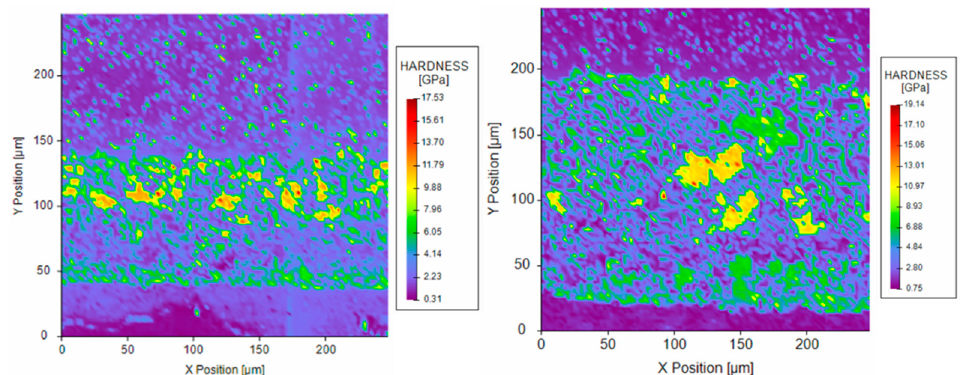
modulus of elasticity contour plot ( Right ). A diffusion zone clearly formed and multiple intermetallic compounds developed at the particle/substrate interfacial region ( Left ). Note that the mounting material is also captured in ( Right ) as the purple region, whereas the red/orange/yellow region is the copper coating and the yellow/green region is the substrate. Similarly, between the ( Left ) “Y Position” value of 200 to 250 μ m is just the substrate material.